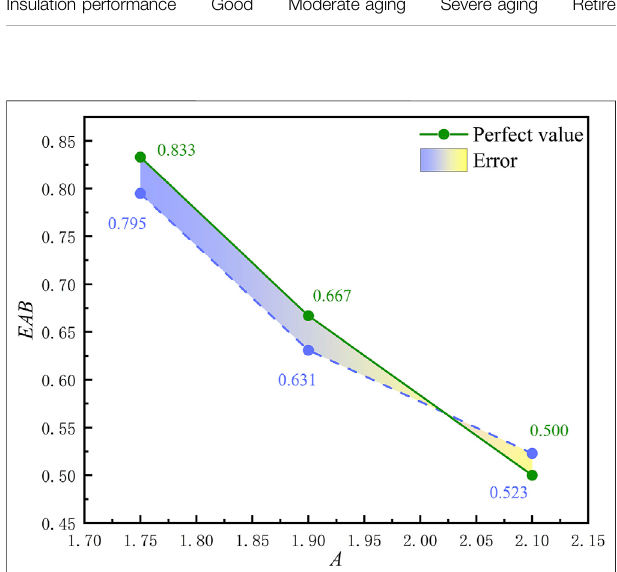
FIGURE 6 | Perfect and measured values of EAB at the state boundary point of